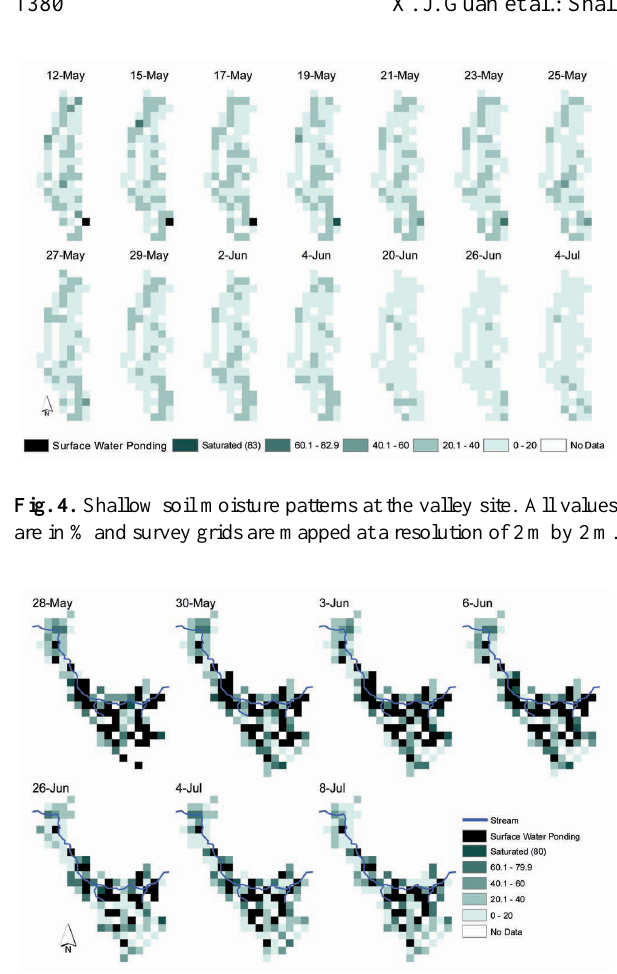
Fig. 5. Shallow soil moisture patterns at the wetland site. All values are in % and survey grids are mapped at a resolution of 15m by 15m.